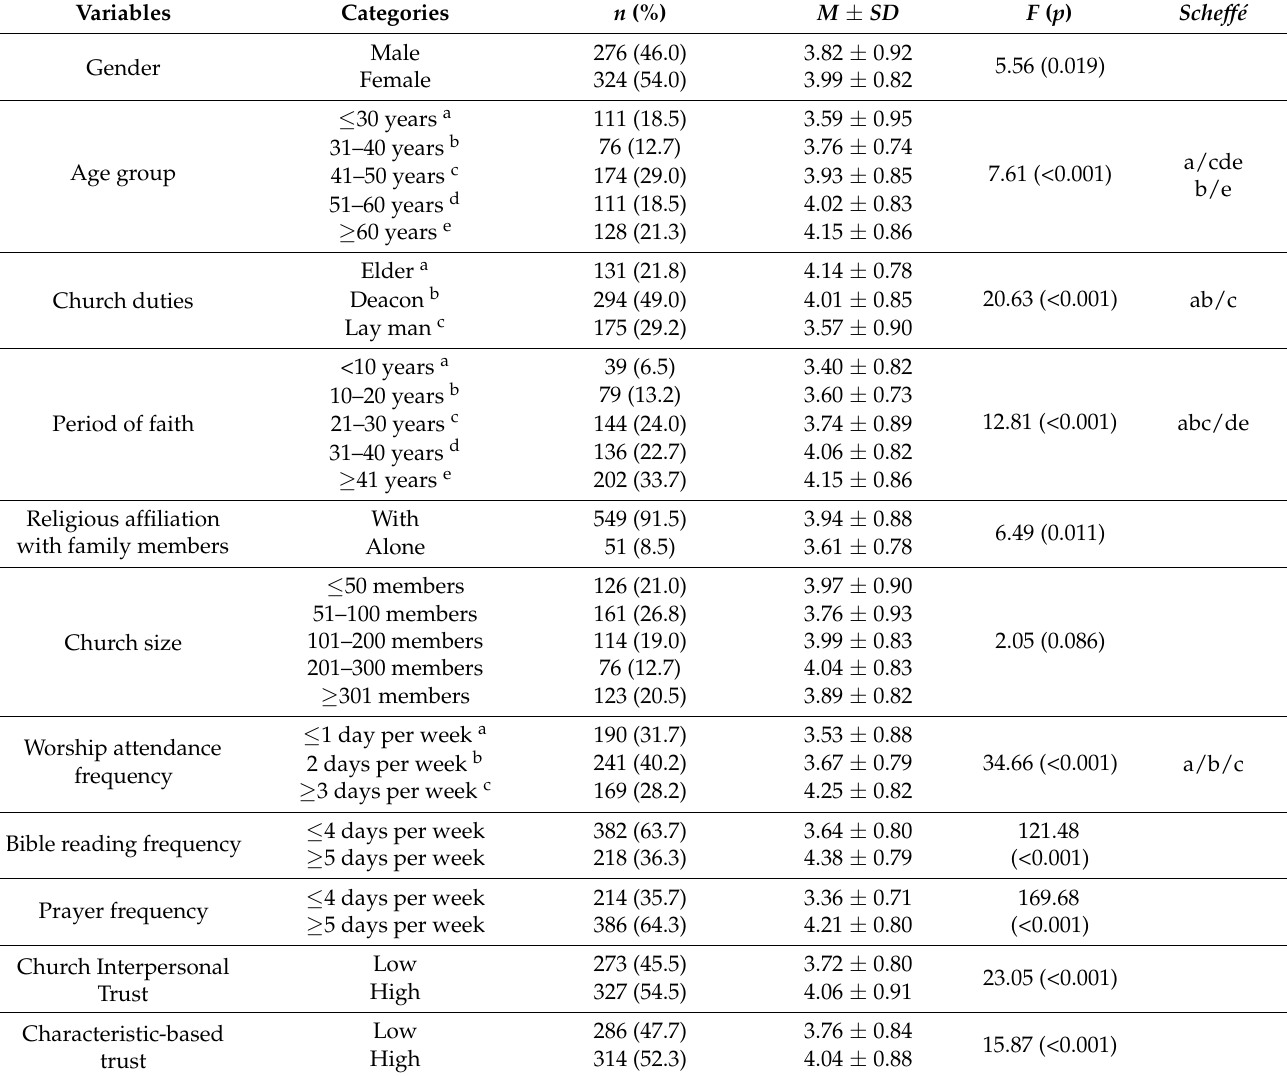
Table 1. Differences in the spiritual experience according to the general and religious characteristics and church interpersonal trust of participants ( n =